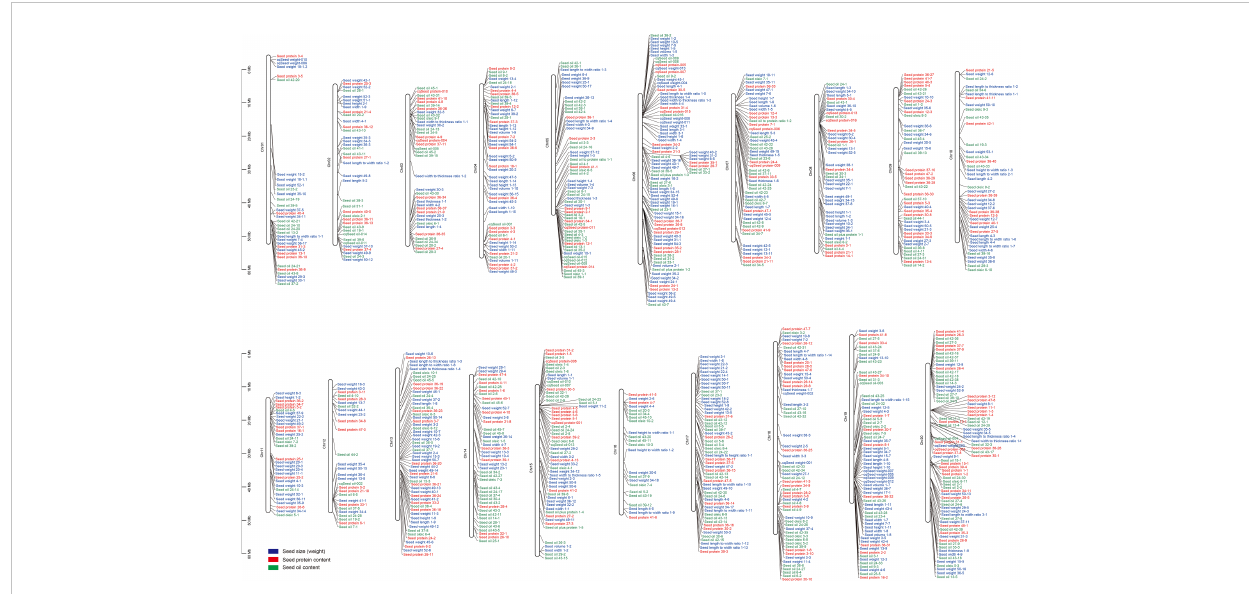
FIGURE 2 QTLs related to seed size (weight), oil accumulation, and protein content in soybean. These QTLs are derived from the SoyBase database